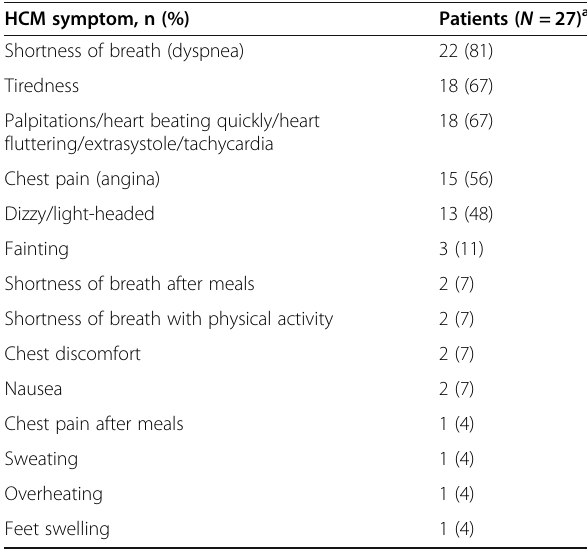
Table 4 Symptoms identified as most important to patients during the concept elicitation interviews